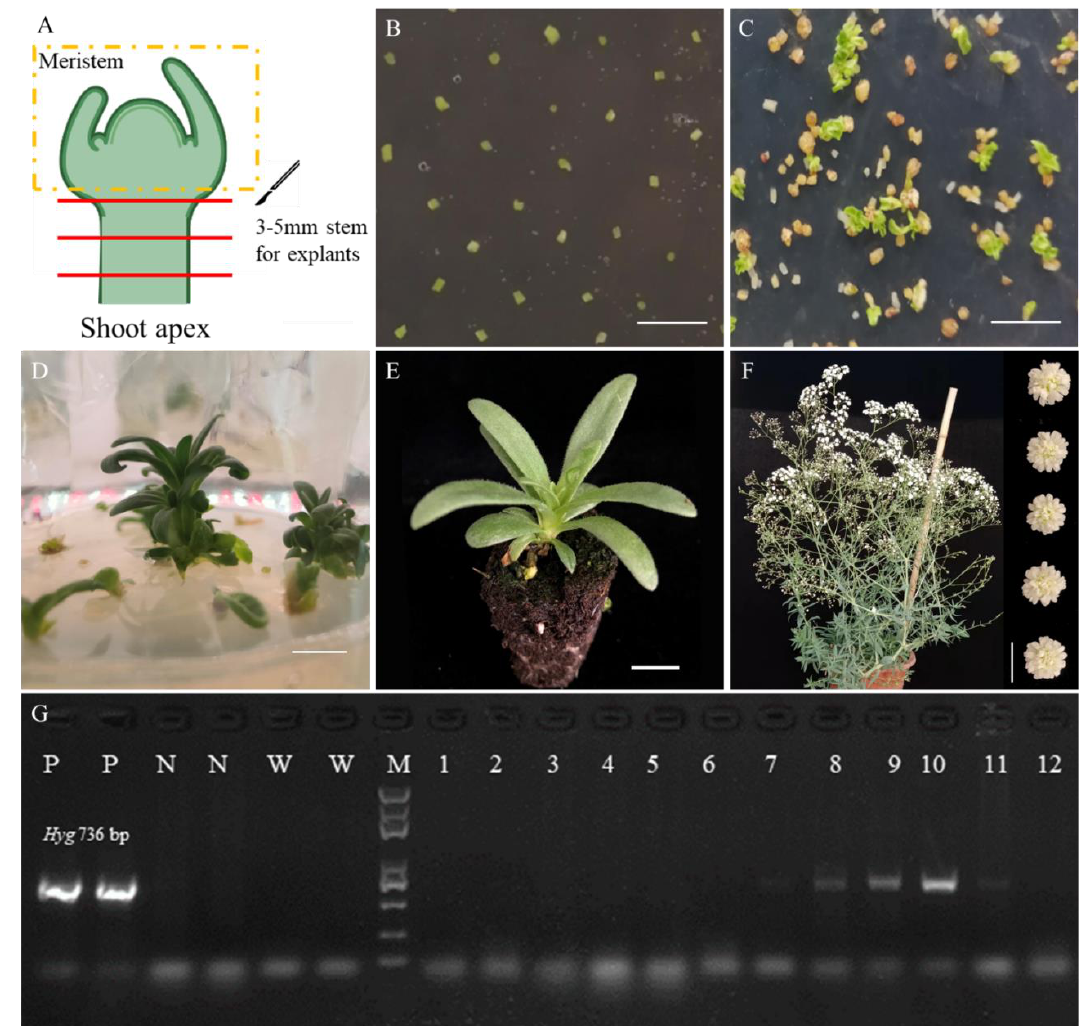
Figure 3. Construction of PgF 3′5′ H transgenic G. paniculata . ( A ), the schematic diagram of explants ’ acquisition; ( B ), the freshly cut explants; ( C ), regenerated shoots under first selection; ( D ), surviving regenerated shoots after second selection; ( E ), rooted seedlings on soil; ( F ), grown-up transgenic ‘YX 4 ’ plant and flowers; ( G ), represented gel of PCR verification ( p , plasmid; N, Non-transgenic plant; W, water; M, DNA ladder; 1 – 12, Hyg-resistant plantlets), Scale bar = 1 cm.